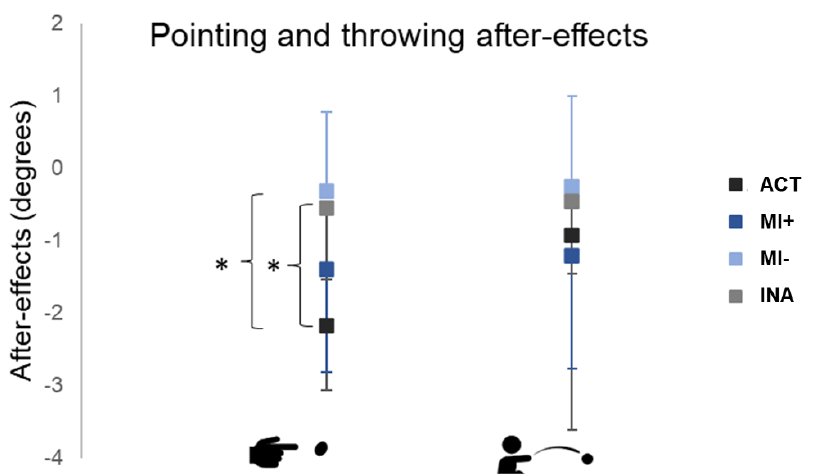
Figure 5. Pointing and throwing after-effects. Performances during post-tests with the baseline subtracted. Values are reported with standard deviations. * means p < 0.01. ACT: active group; MI: motor imagery groups with higher (+) versus lower ( − ) MI abilities; INA: inactive group.